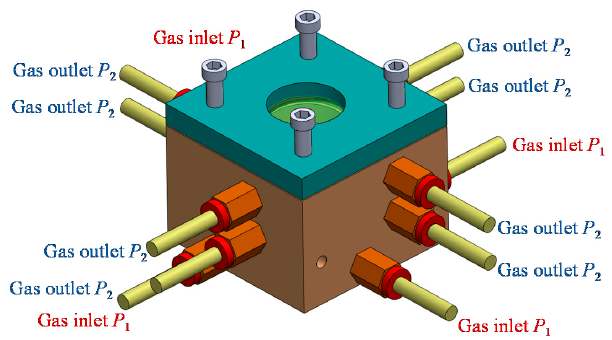
Figure 2. Design of swirling gas jet nozzle with eight outlet tubes and four direction inlet tubes.